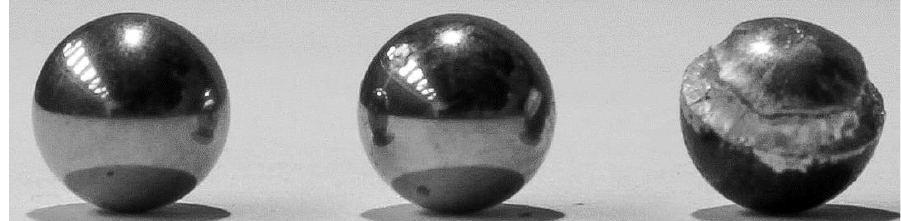
Fig. 4 Comparison between an unused ball bearing (left), ball bearing after a 570 m/s gas gun tests (centre) and a ball bearing after blasting